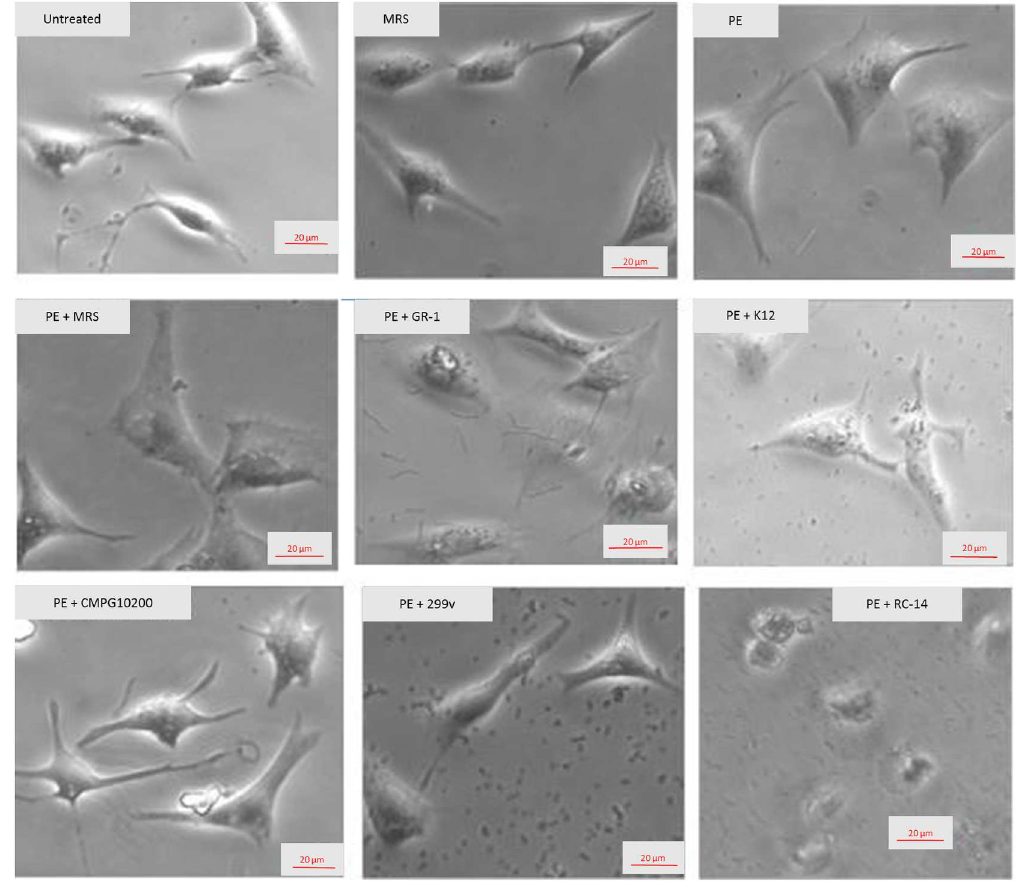
Fig 1. Representative micrographs illustrating NVCM exposed to PE alone or with probiotics. The control NVCM were either untreated, or co-culturedwith MRS broth. Originalmagnification = 20 × .